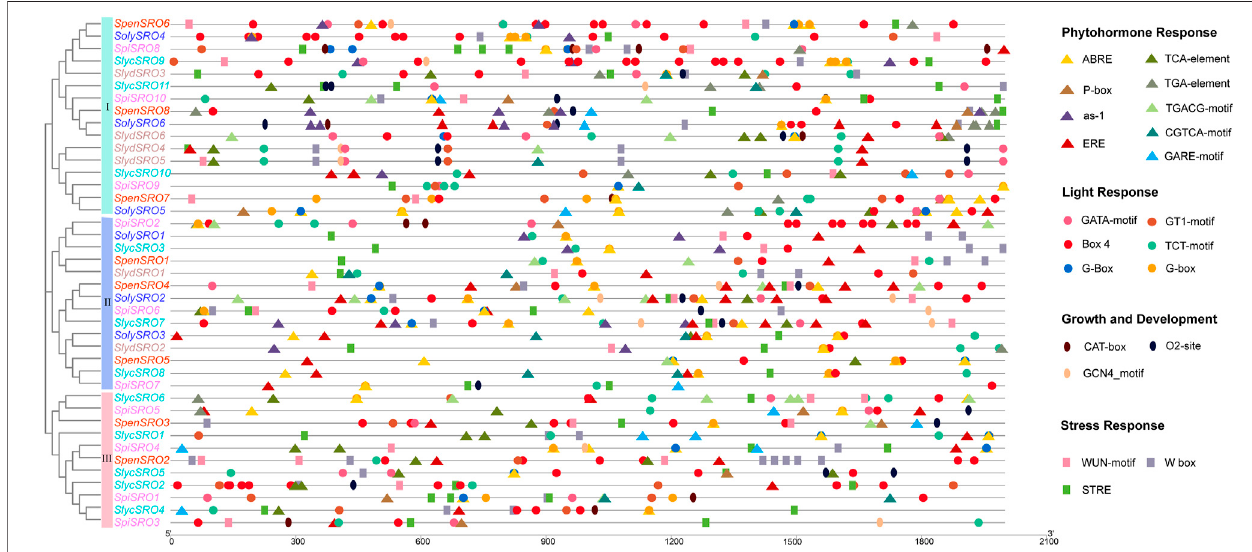
FIGURE 3 | Distribution of CREs of SRO genes in tomato. The different coloured SRO genes were derived from different tomato species. Different CREs were indicated by different shapes, triangles indicate hormone response elements, circles indicate light response elements, ellipses indicate growth and development related elements, boxes indicate stress response related elements, and different elements were indicateed by different